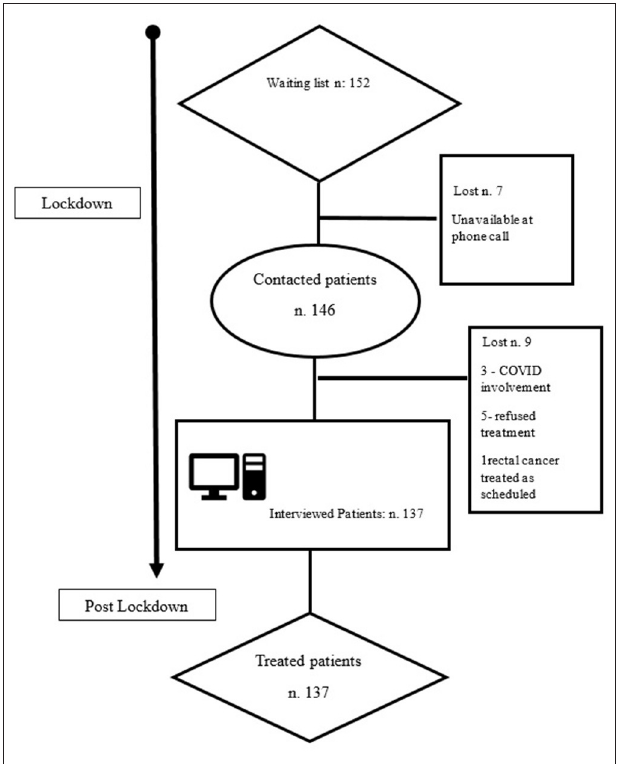
FIGURE 1 | Recruitment process